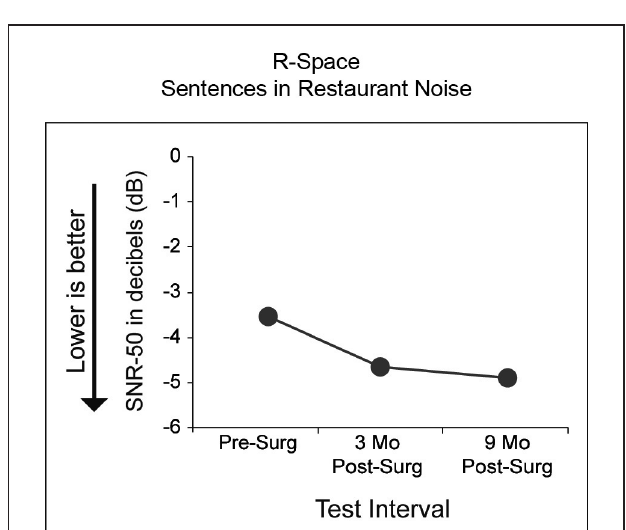
range from − 70 degrees toward the NH ear side at the bottom of the axis to + 70 degrees toward the hearing-impaired ear side at the top of the axis. Symbols indicate mean responses for each active sound-source location and error bars represent ± 1 standard deviation. Mean RMS Error in degrees is noted within the plot for each test interval. Asterisks in Panels B and C indicated significantly improved localization results compared to pre-surgery ( p < 0.001).